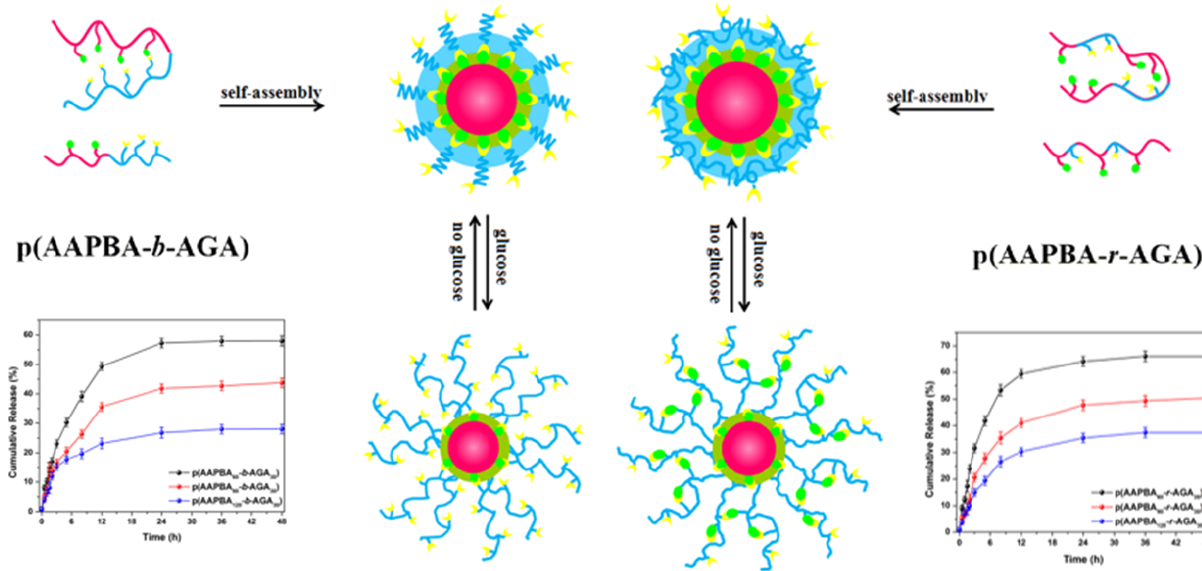
Figure 4: Schematic illustration for the self-assembly and insulin release behaviors of block and random copolymeric nanoparticles. Adapted with permission from [38]. Copyright 2015, American Chemical Society